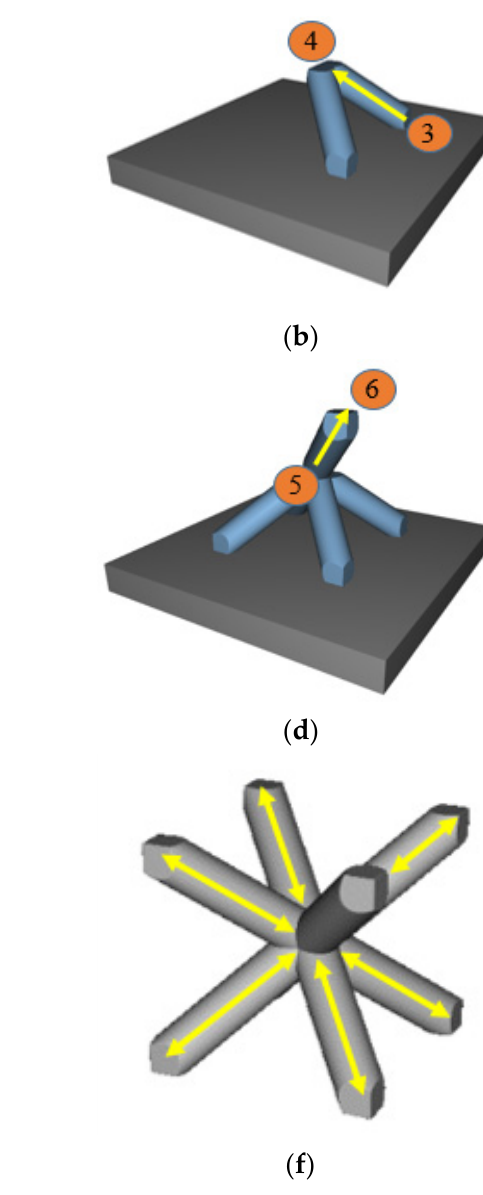
Figure 4. ( a ) Nozzle start and end positions for printing the 1st beam of a BCC unit cell via ALE; ( b ) start and end positions for printing the 2nd beam; ( c ) completed beams for the bottom half of the unit cell; ( d ) start and end nozzle positions for printing the 1st beam on the top half of a unit cell; ( e ) completed unit cell that includes beam orientation angles; ( f ) lattice unit cell illustrating expected orientation of carbon fibers with the longitudinal axis of each cylindrical beam in the BCC unit cell.